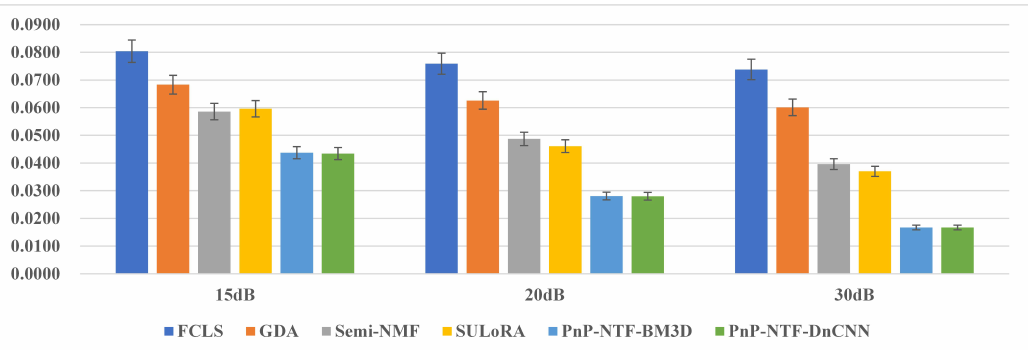
Figure 4. Evaluation results of RMSE with the proposed method and state-of-the-art methods on ‘Scene1’.